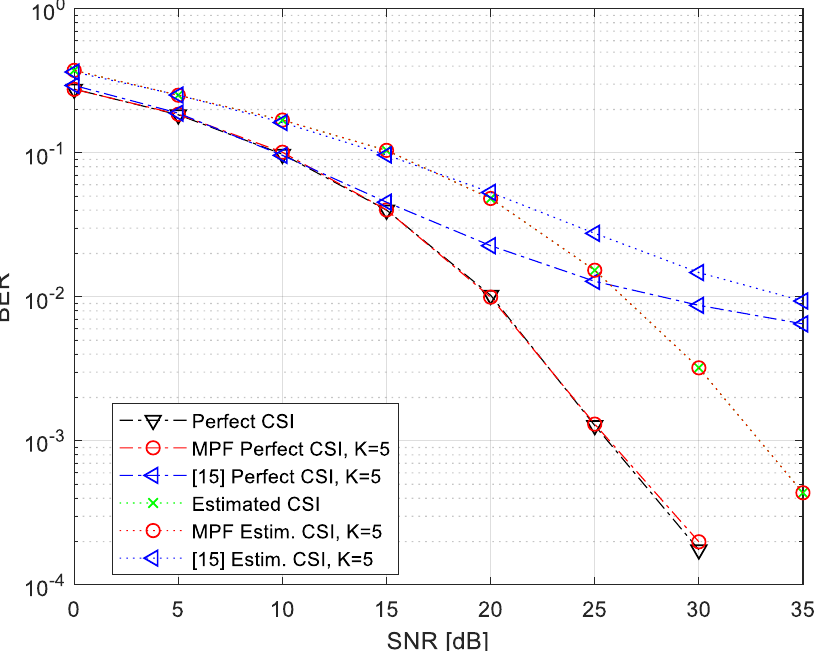
Figure 3. Performance of the equalizers [15] and the proposed 5-MPFs with 16-QAM modulation